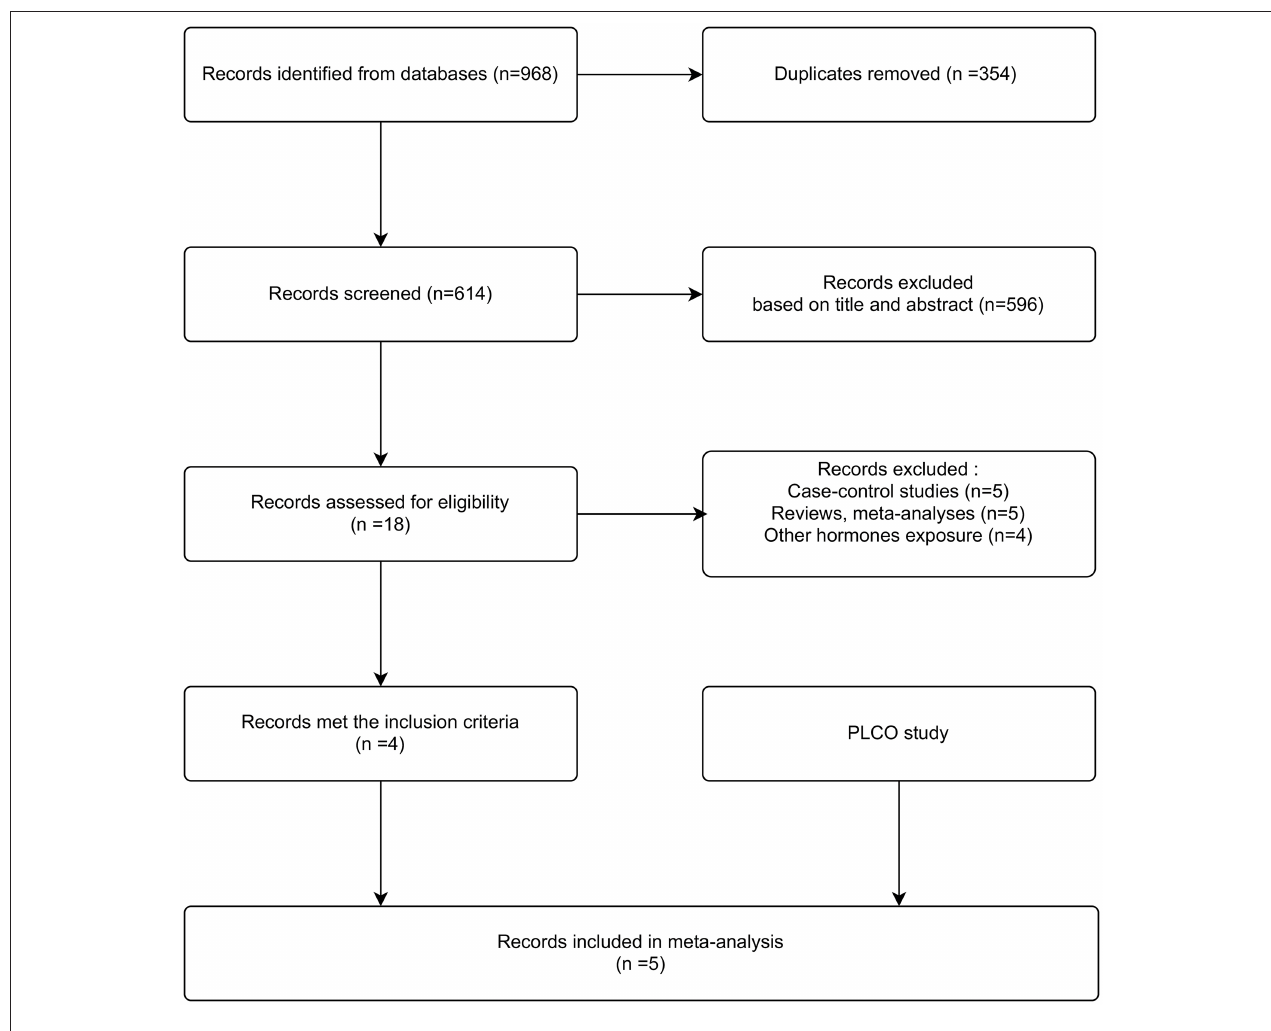
FIGURE 2 | Flowchart for the study selection process.